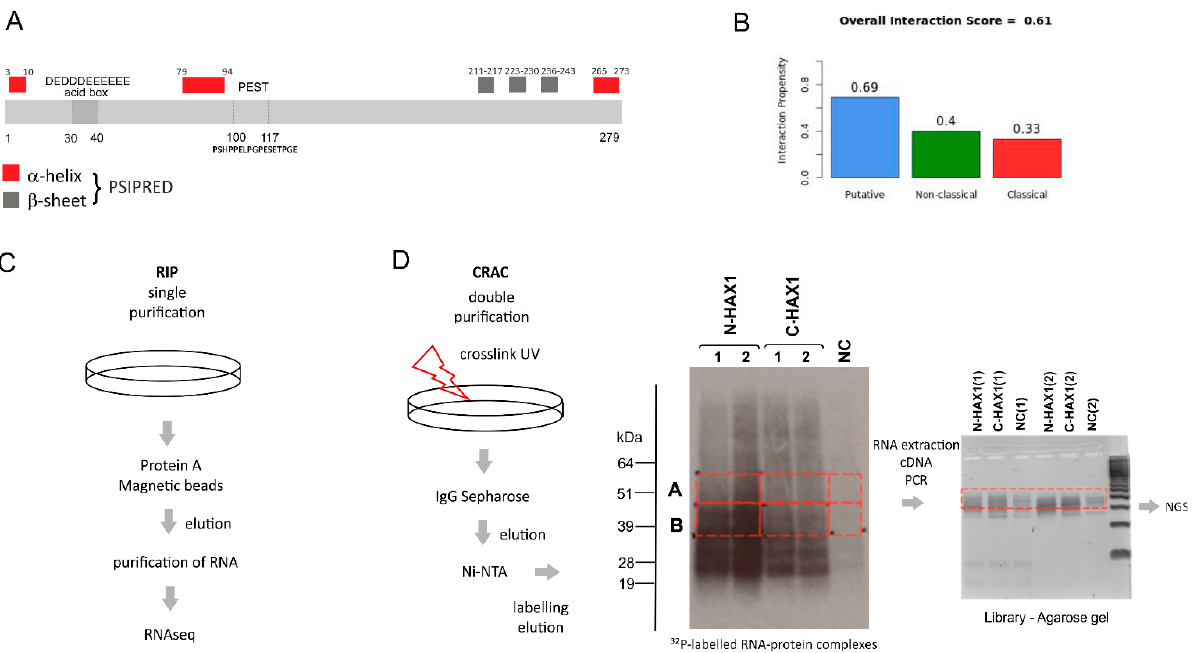
Figure 1. Experimental design of HAX1–RNA interactome studies. ( A ) HAX1 amino acid sequence with characteristic features and regions (acid box, PEST domain, structural elements predicted using PSIPRED (PSI-blast-based secondary structure PREDiction)). ( B ) CatRapid prediction of HAX1 RNA binding propensity classifies it as a putative RBP, but binding does not occur via classical elements. ( C ) Schematic of RIP experiments: no crosslink, single purification step with HAX1-specific antibody. ( D ) Schematic of CRAC experiments, sequential steps: UV crosslink of RNA targets, double purification with Sepharose and NiNTA resin, isotope labeling and extraction of the RNA–protein complexes from polyacrylamide gel, RNA extraction, reverse transcription, PCR, and next generation sequencing of the RNA targets.